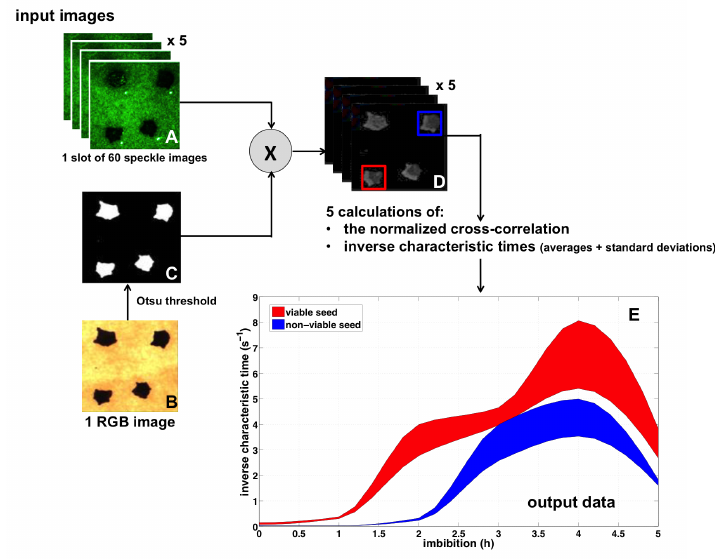
Figure 4. Main steps of the image processing pipeline performing the calculations of the normalized cross-correlation and inverse characteristic times of a typical sequence of speckle images with four sugar beet seeds in imbibition. Seeds in the upper line (blue square) are non-viable, whereas seeds in the lower line (red square) are considered as viable. Considering the five slots, the average value and standard deviation are also accessible, as depicted in the output